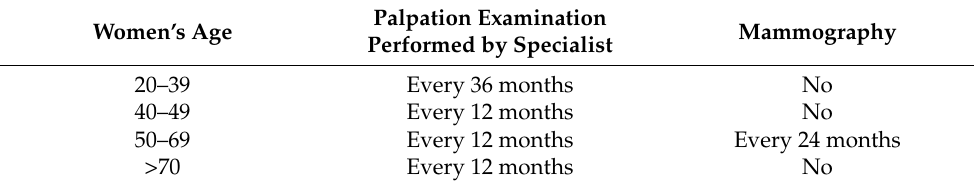
Table 1. The frequency of follow-up in asymptomatic women with no risk factors for breast cancer. Palpation Women’s Age